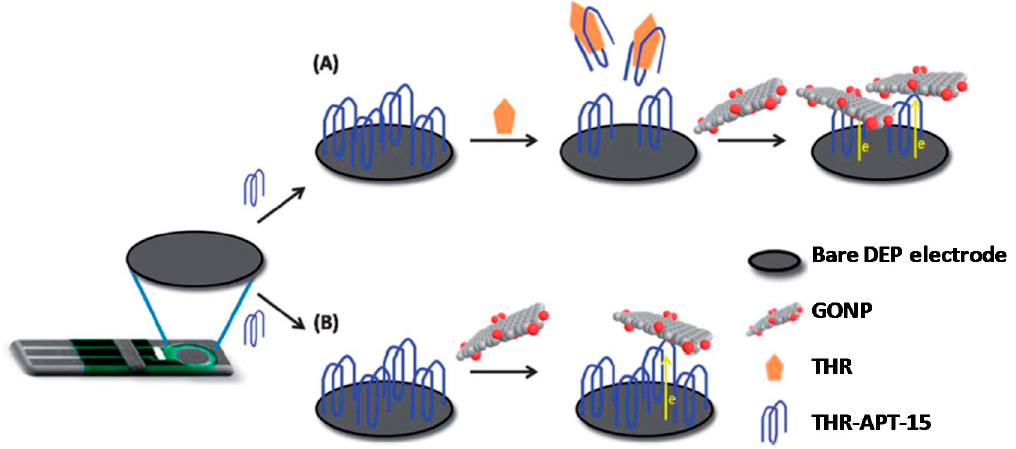
Figure 4. Illustration of the utilization of GO nanoplatelets (GONPs) in label-free electrochemical aptasensing of thrombin. See the text for more information. Reprinted and adapted from [13] with permission.